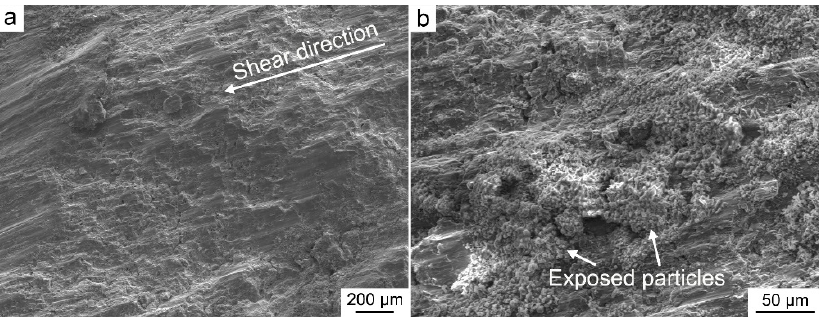
Figure 5. Shear fractures of the 8.2AlN in /Mg–8Al composite: ( a ) low magnification; ( b ) high magni- fication.